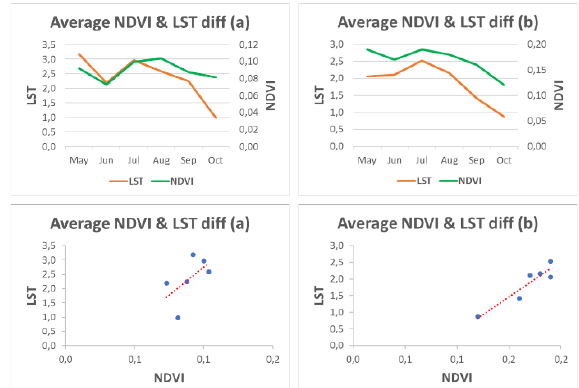
Figure 1 . The average difference in NDVI and LST between inside and outside the green area for sample area 1 (a) and sample area 2 (b)